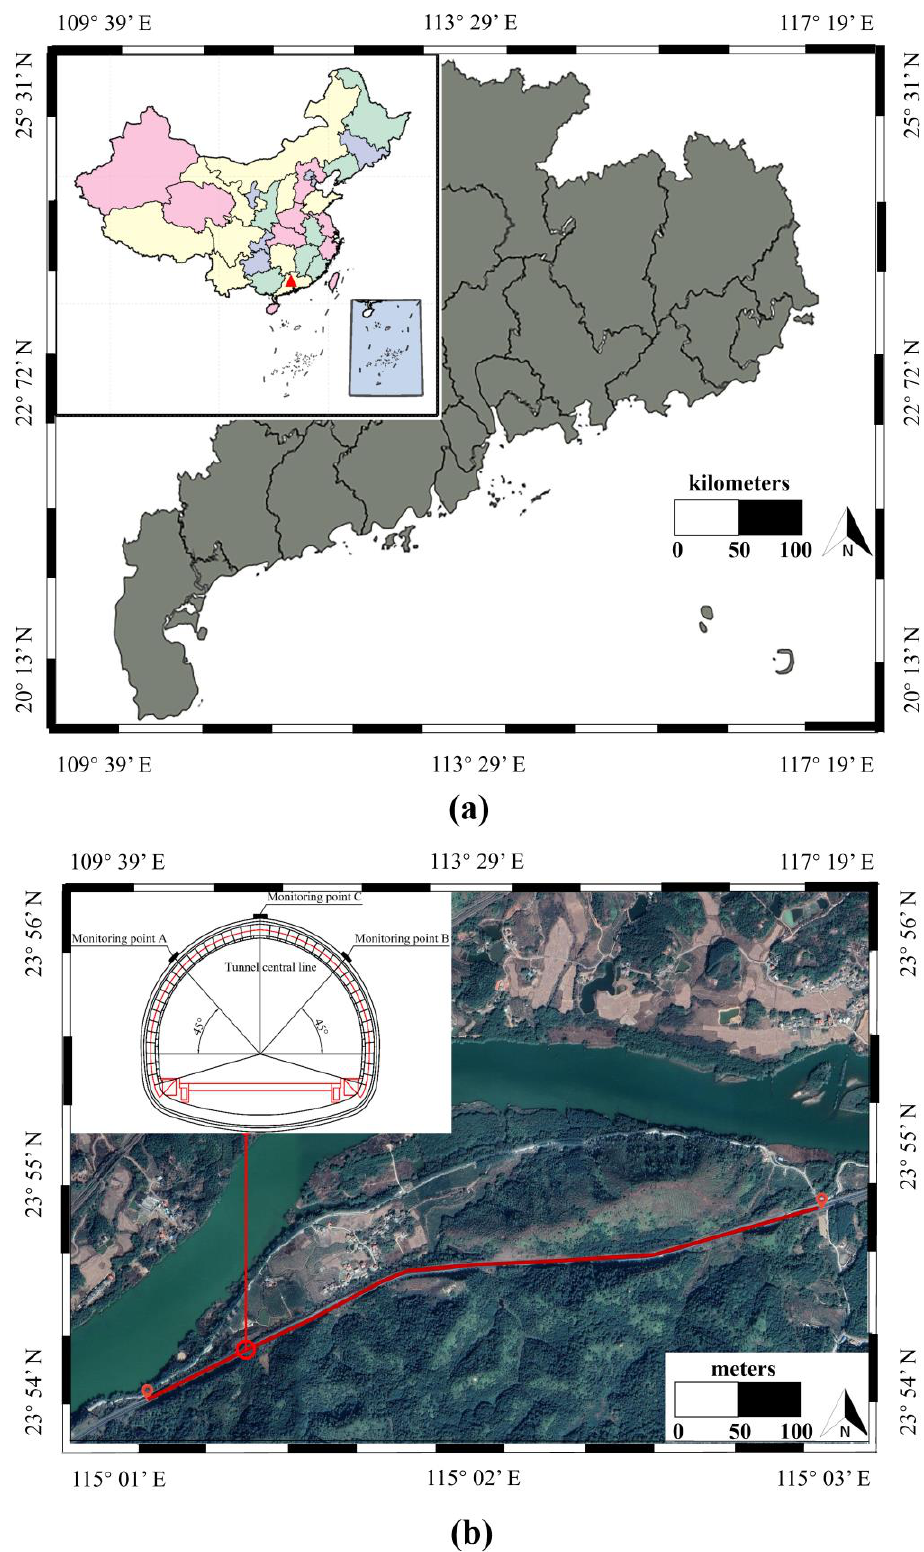
Figure 5. Site selection and representative monitoring section of a coastal tunnel in South China. ( a ) Project area; ( b ) a section of the tunnel.